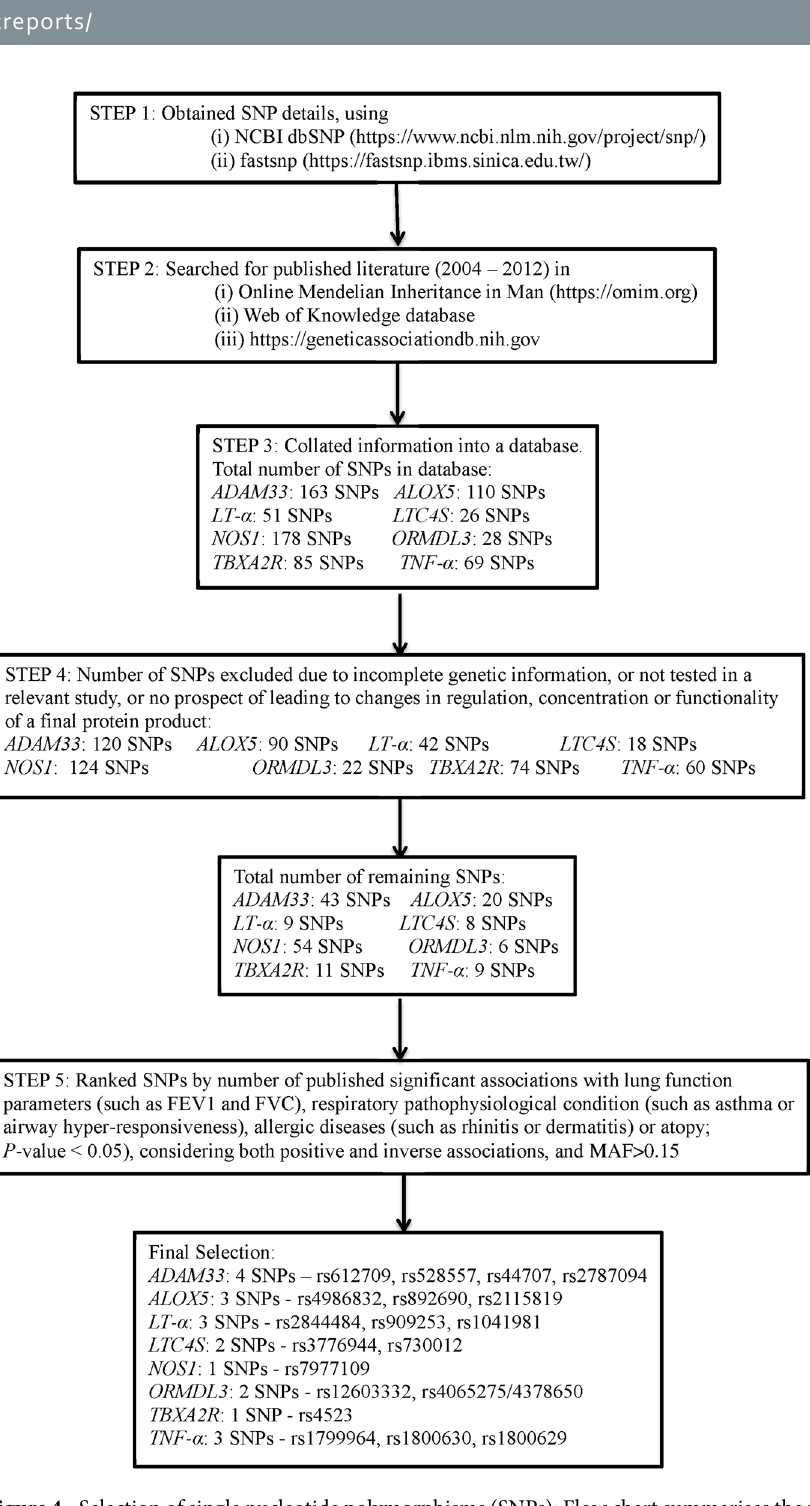
Figure 4. Selection of single nucleotide polymorphisms (SNPs): Flow chart summarises the procedures for the selection of SNPs in the study. MAF: minor allele